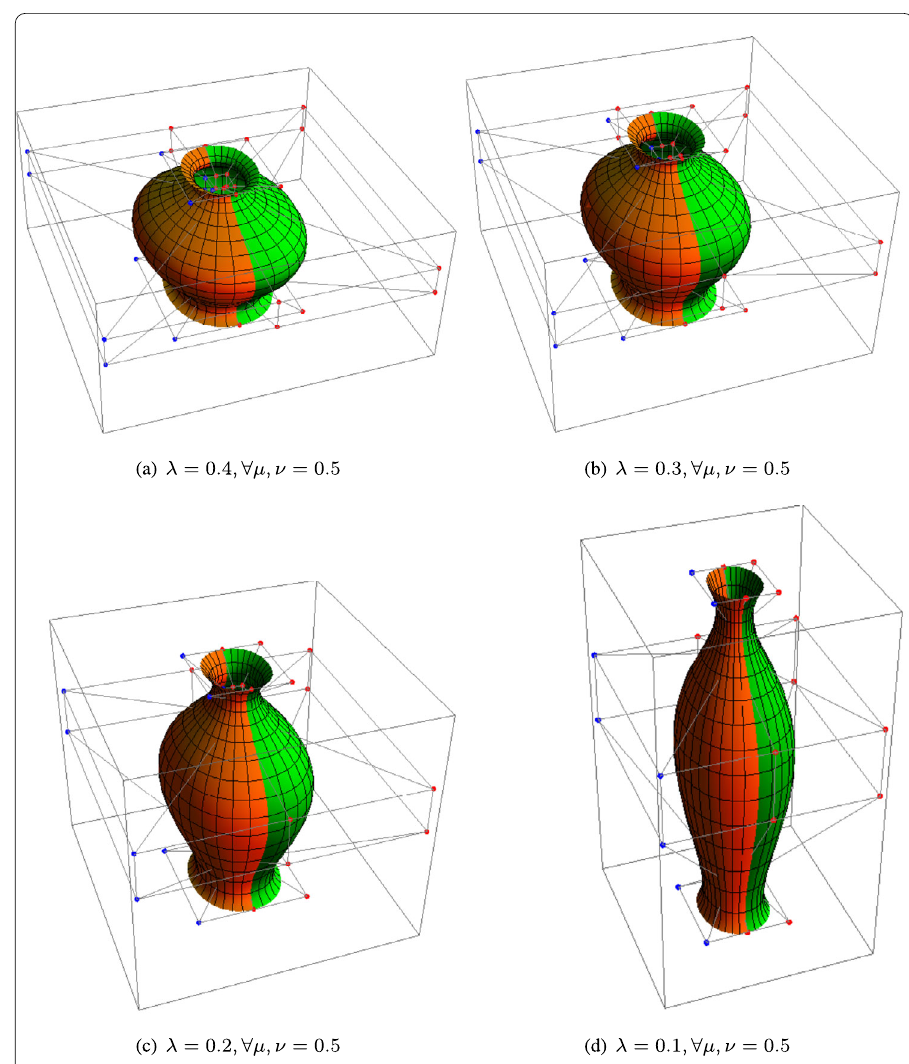
Figure 16 C 1 continuous connection among two GBT-Bézier swung surfaces with different scale factor λ